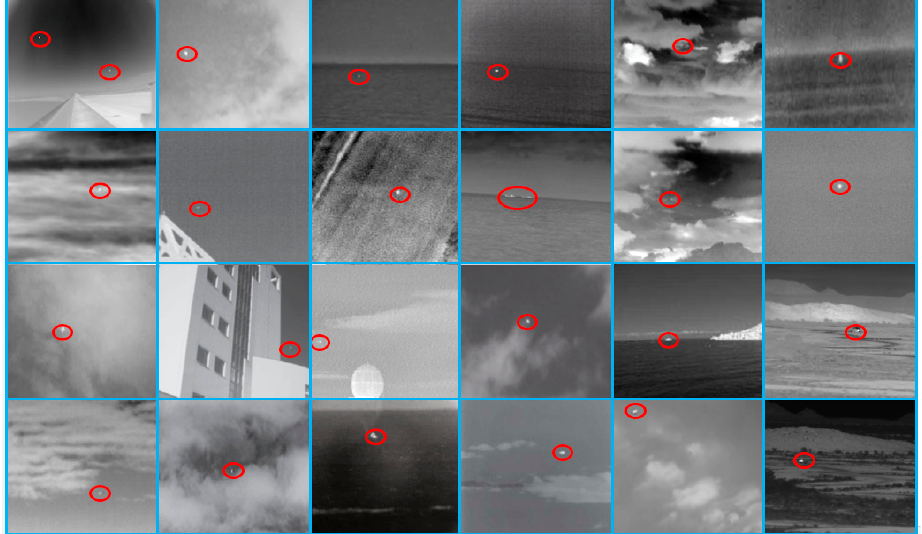
Figure 6. NUAA–SIRST dataset, where the red circles are the targets.